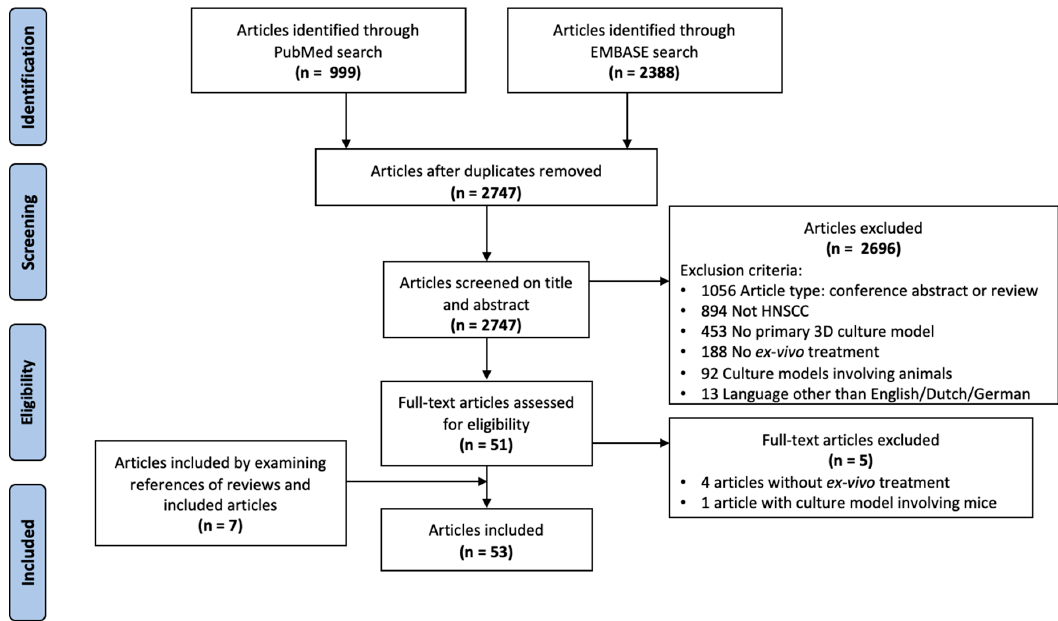
Figure 1. Flow diagram of the systematic literature search performed.